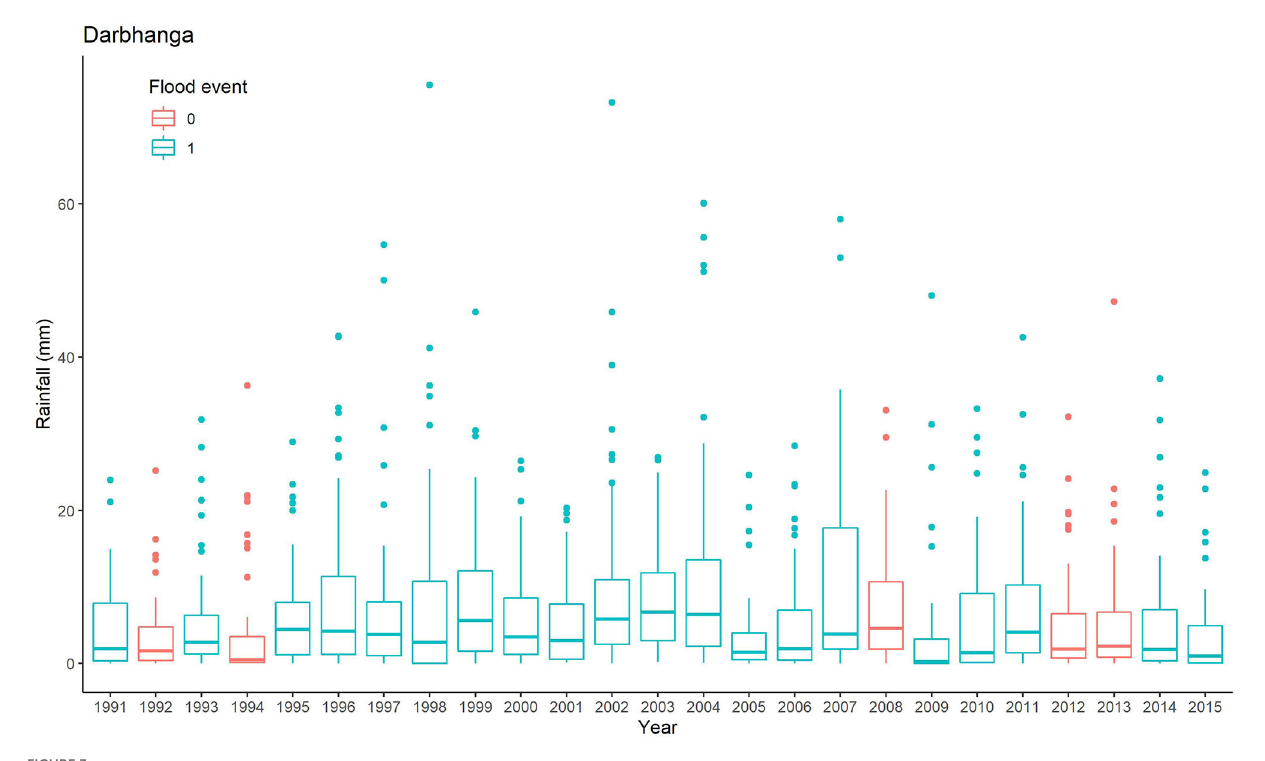
FIGURE3 Darbhanga_monthly rainfall _flood